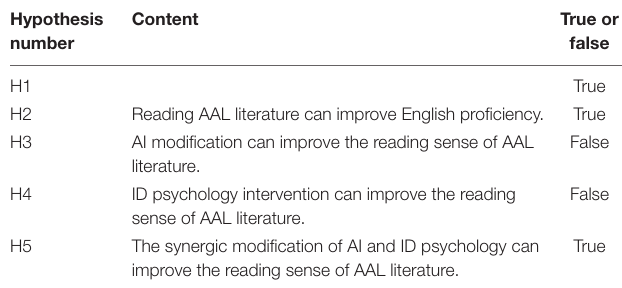
TABLE 7 | Hypothesis test